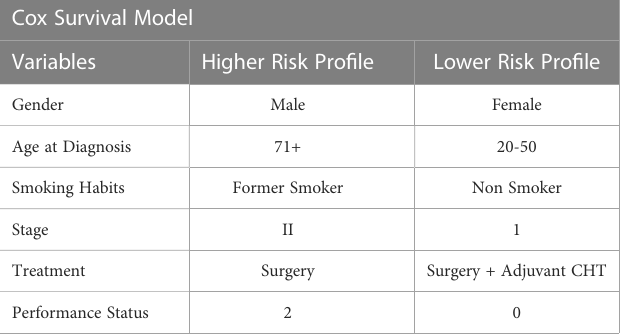
TABLE 4 Prognostic model of survival including signi fi cant variables from the multivariate analysis. Cox Survival